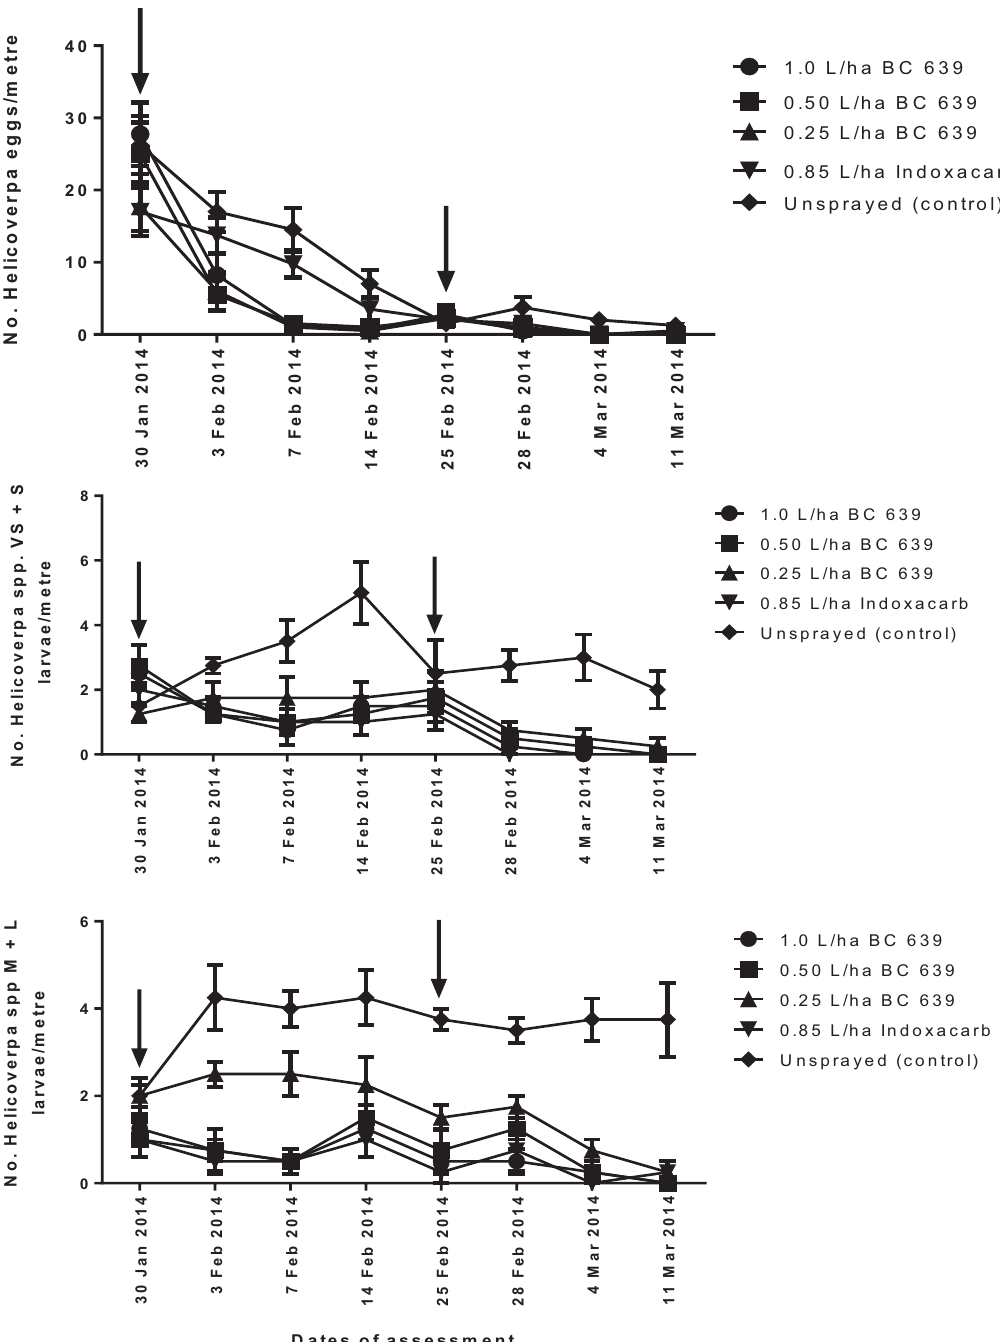
Figure 4. The efficacies of different rates of application of BC 639 and synthetic insecticide (Indoxacarb) on reducing the numbers of Helicoverpa spp. ( A ) Eggs, ( B ) very small + small (VS + S) larvae ( i.e ., Instars 1 – 3) and ( C ) medium + large (M + L) larvae ( i.e ., Instars 4 – 6) per metre on commercial conventional cotton crops at Norwood near Moree, 2007 – 2008. The arrows indicate the date of